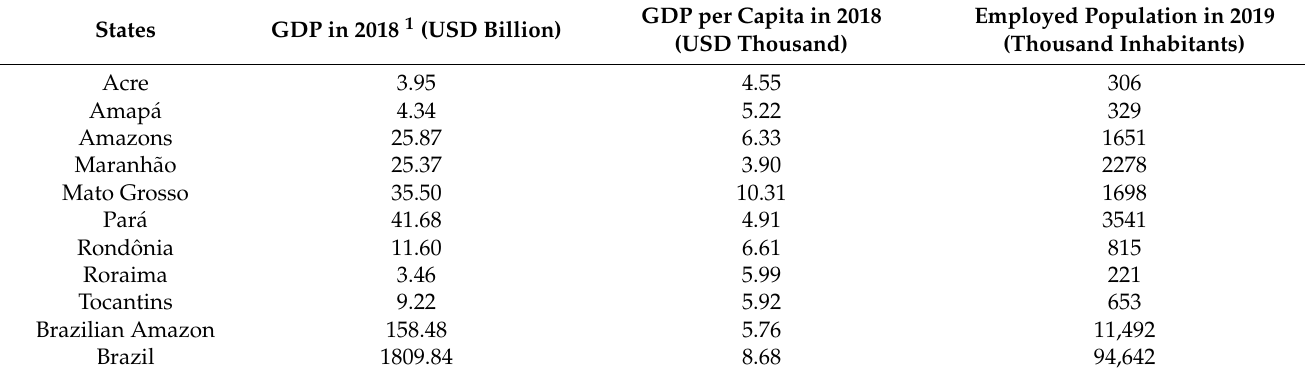
Table 3. Total and per capita real GDP in the Brazilian Amazon states and Brazil in 2018. Source: [21].